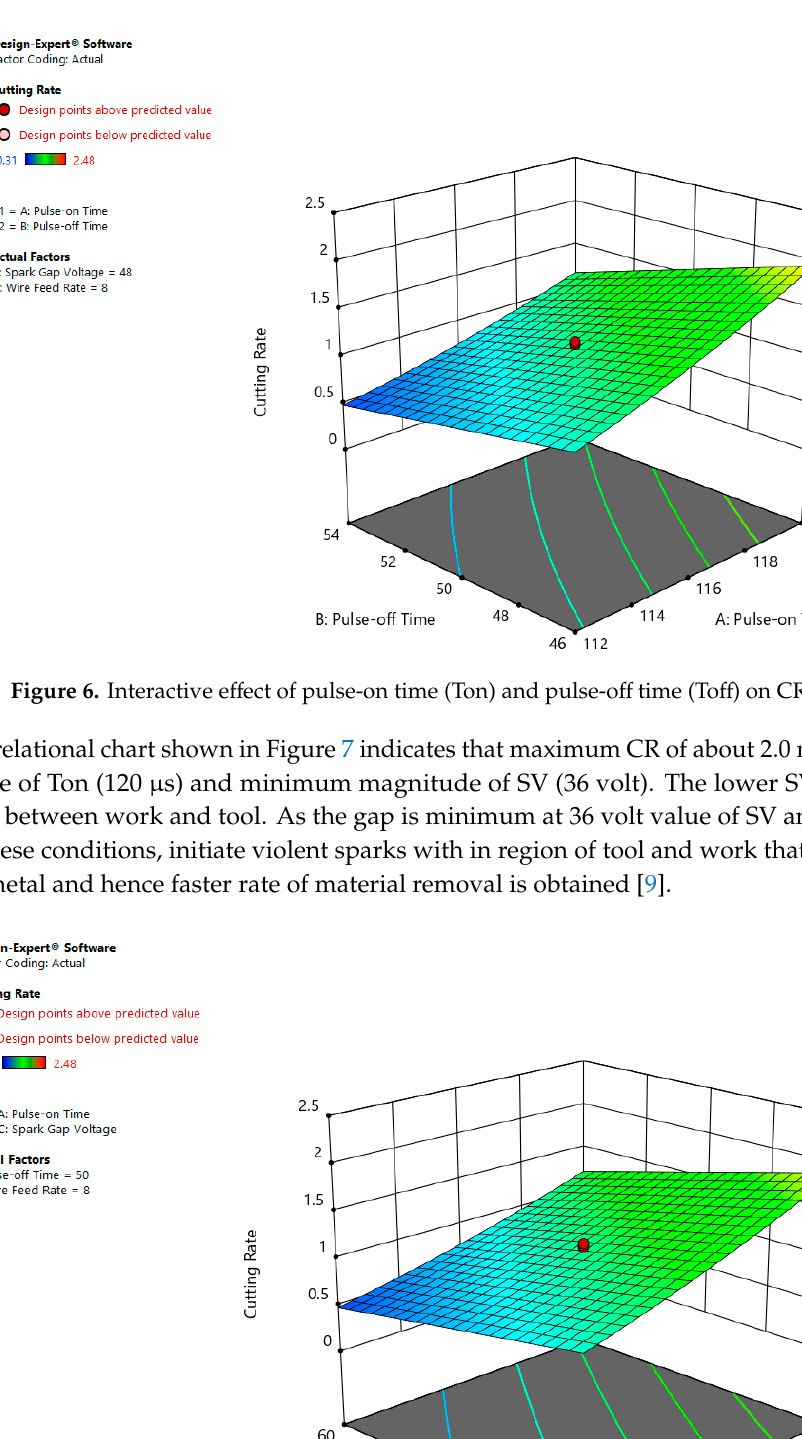
Figure 7. Interactive impact of Ton and SV on CR.